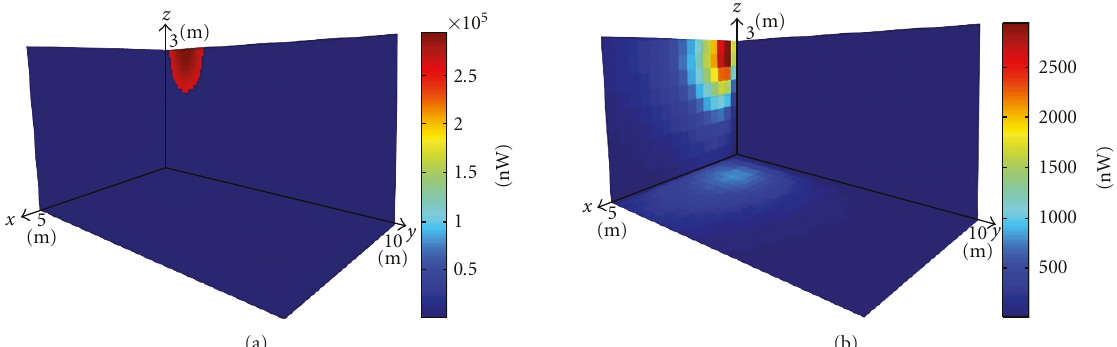
Figure 6: The surface power distributions of the walls for (a) LOS simulation and (b) nondirection di ff use simulation.